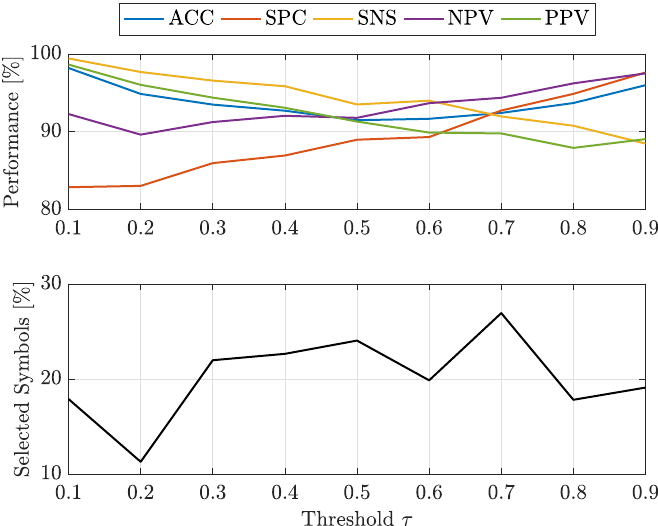
Figure 5. Average Performance on Test Set for Experiment #2 ( (cid:96) 1 -SVM, α = 1).